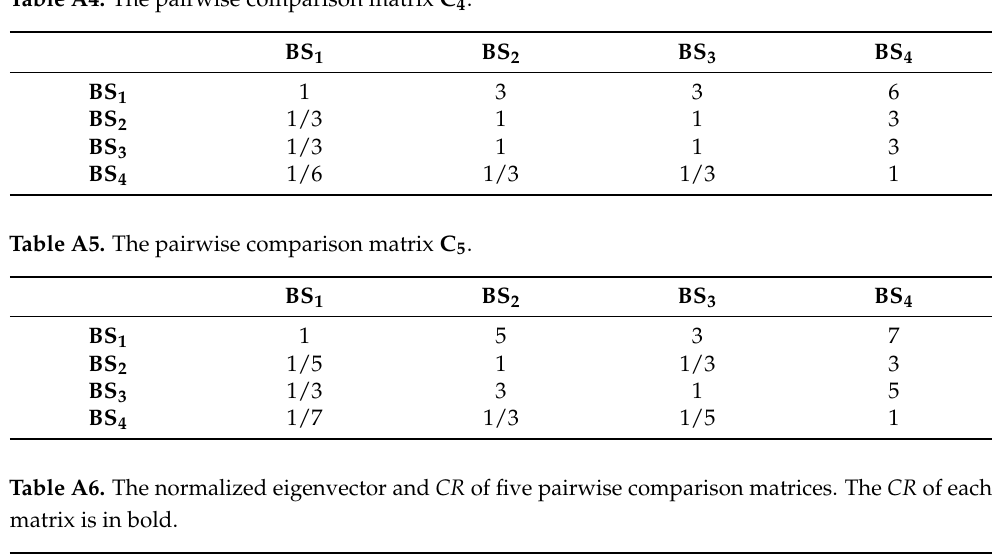
Table A4. The pairwise comparison matrix C 4 .